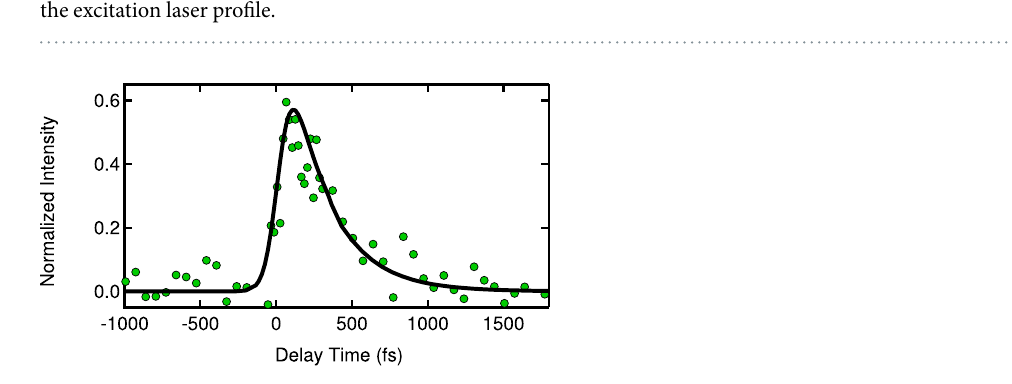
Figure 4. Fitting of the TG time profile. The curve is given by subtracting the value for 120 K from that for 5 K. The fitting is performed by using two decay constants for α = 1 and α =